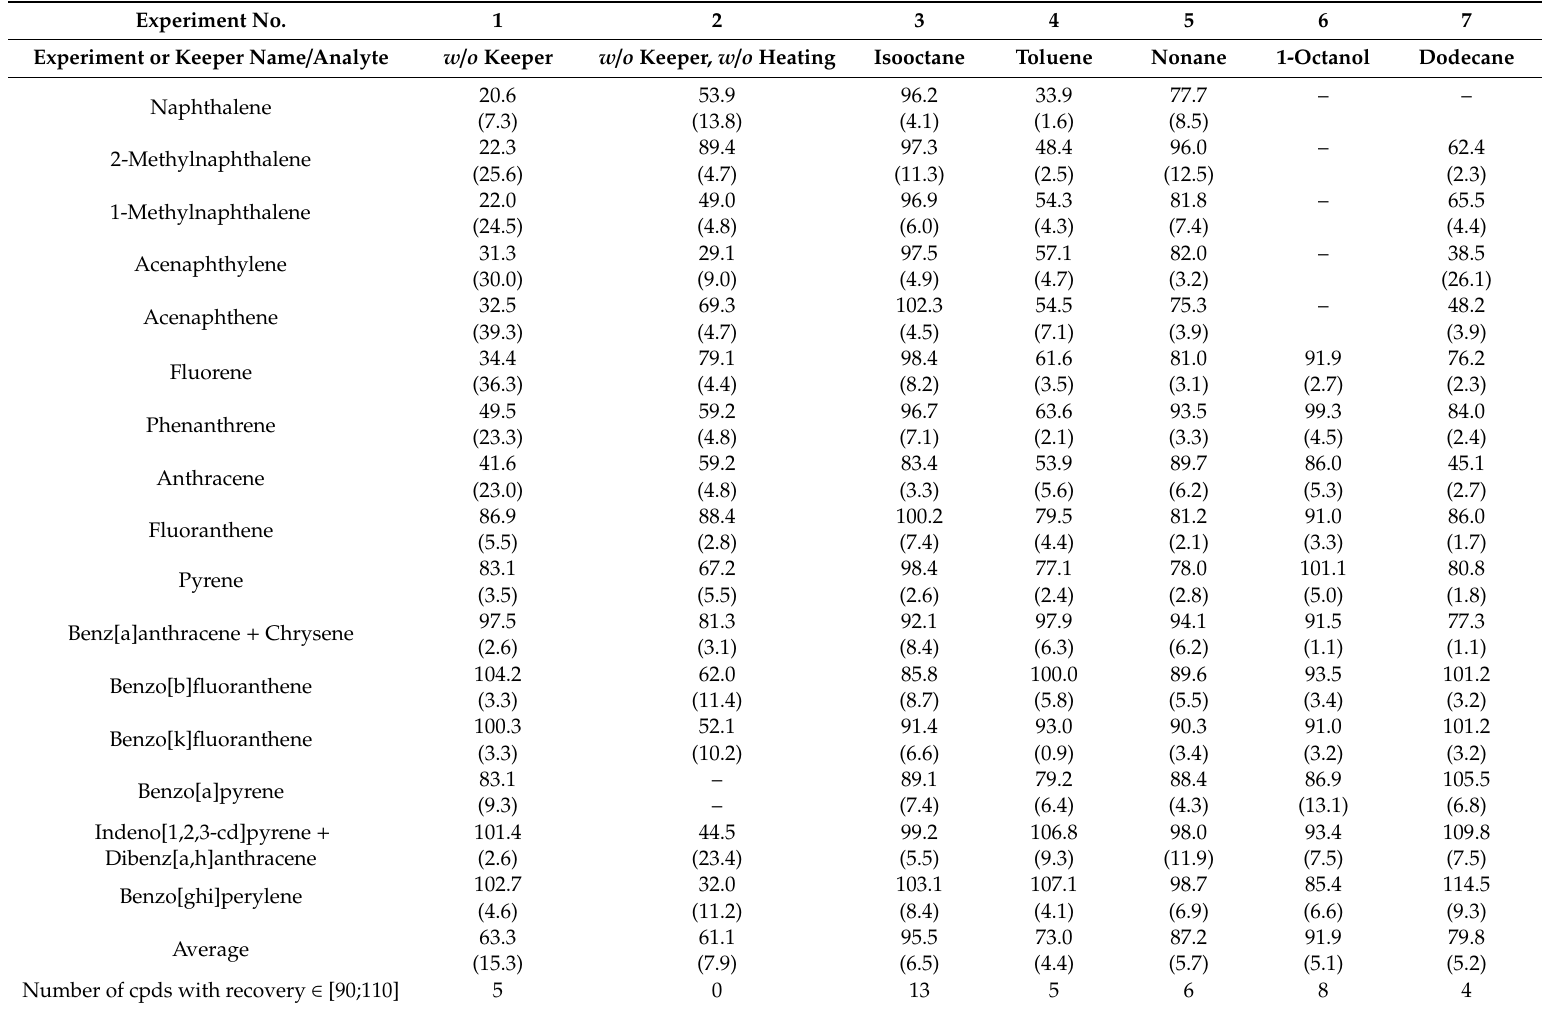
Table 3. Recoveries and RSDs (%) achieved in the polycyclic aromatic hydrocarbon (PAH) evaporation experiments. Experiment